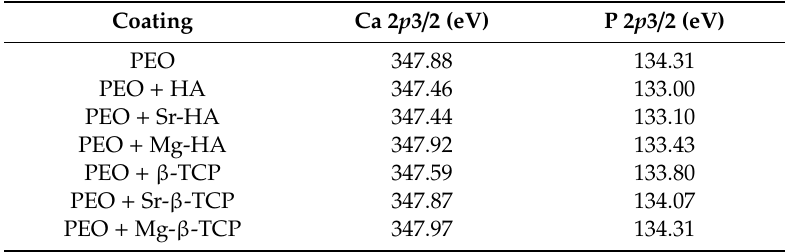
Table 3. Binding energy values of the Ca2 p 3 / 2 and P2 p 3 / 2 XPS peaks.